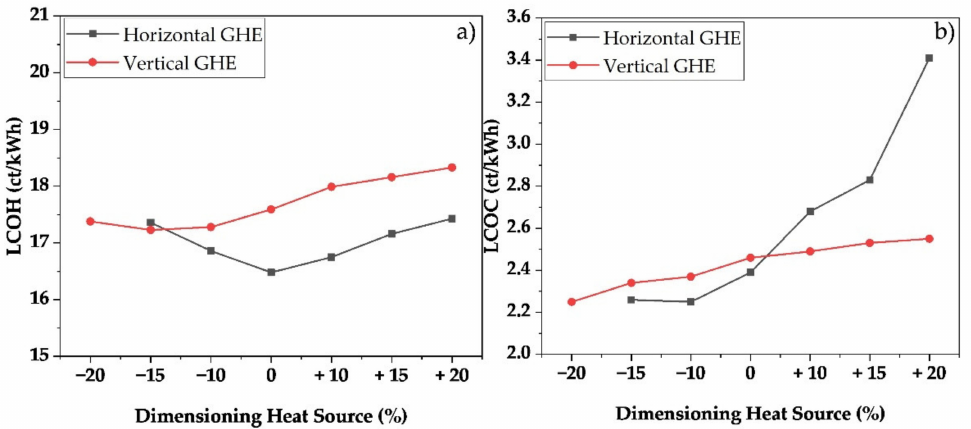
Figure 9. LCOH ( a ) and LCOC ( b ) for various dimensioning of the geothermal heat source for the region of Oslo.